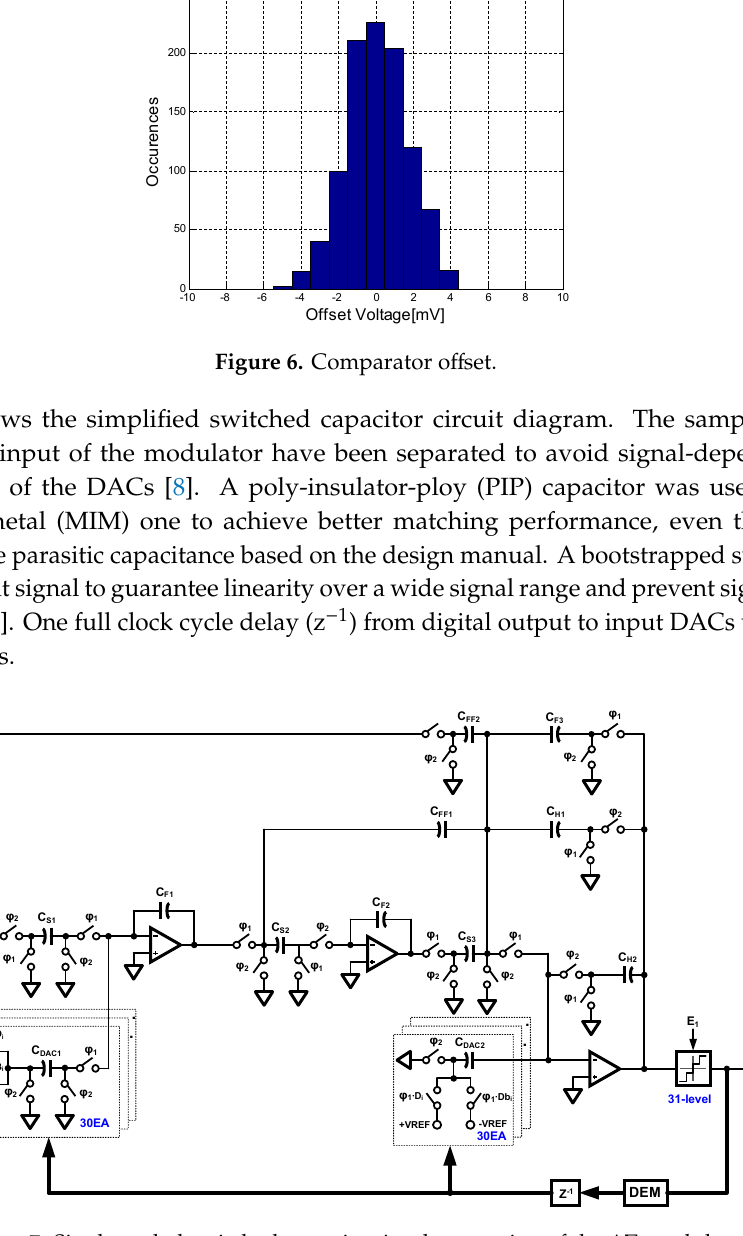
Figure 7. Single-ended switched-capacitor implementation of the ΔΣ modulator.